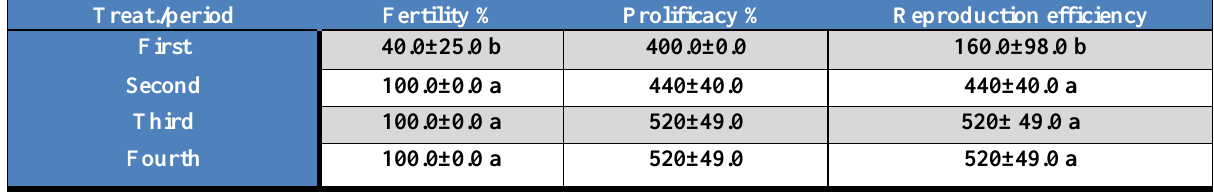
Table, 13: Effect of Vit. C and/or Vit.B on the fertility, prolificacy and reproduction efficiency of rabbits.